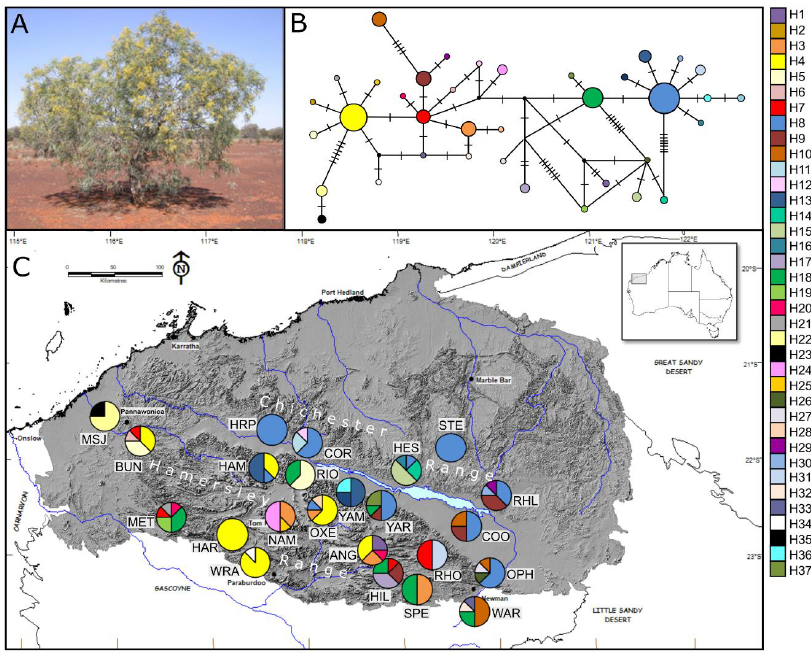
Figure 2. ( A ) A. pruinocarpa at Warrawanda (WAR); photo credit S. van Leeuwen. ( B ) Network of cpDNA haplotypes identified with frequency indicated by circle size and black dashes representing mutational steps. ( C ) Map of the 23 A. pruinocarpa populations with pie charts indicating frequency of haplotypes at each